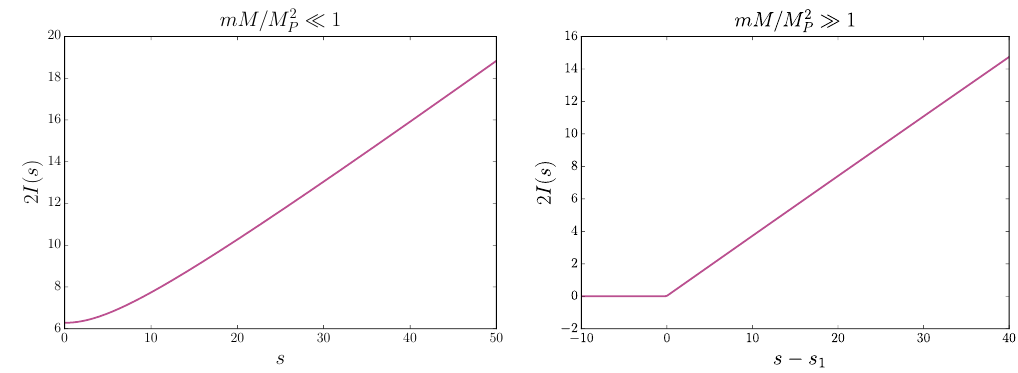
Figure 4 . The barrier integral I ( s ) de(cid:12)ned by eq. (4.28) against s . On the left is this function in the low-mass regime, and on the right the high-mass regime. For large s the behaviour is linear, indicating an exponential dependence of the cross-section on s . In the high-mass regime, this linear behaviour only starts above a critical value s 1 , itself linearly proportional to the particle mass m